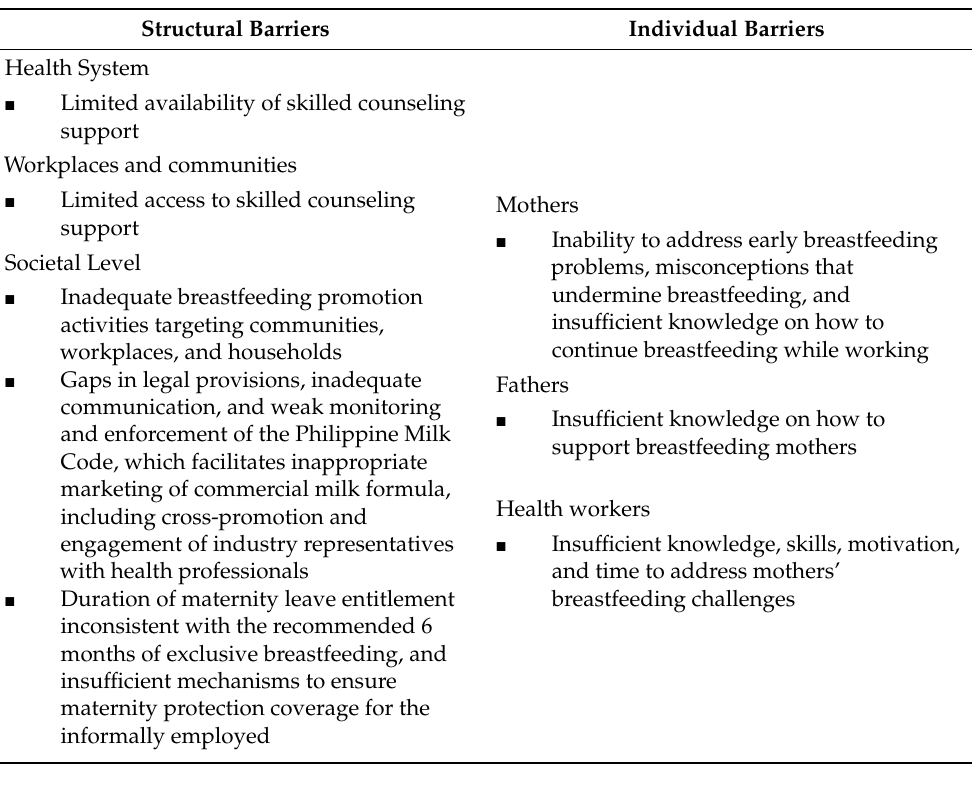
Table 3. Structural and individual barriers that limited the implementation and effectiveness of policies to enable